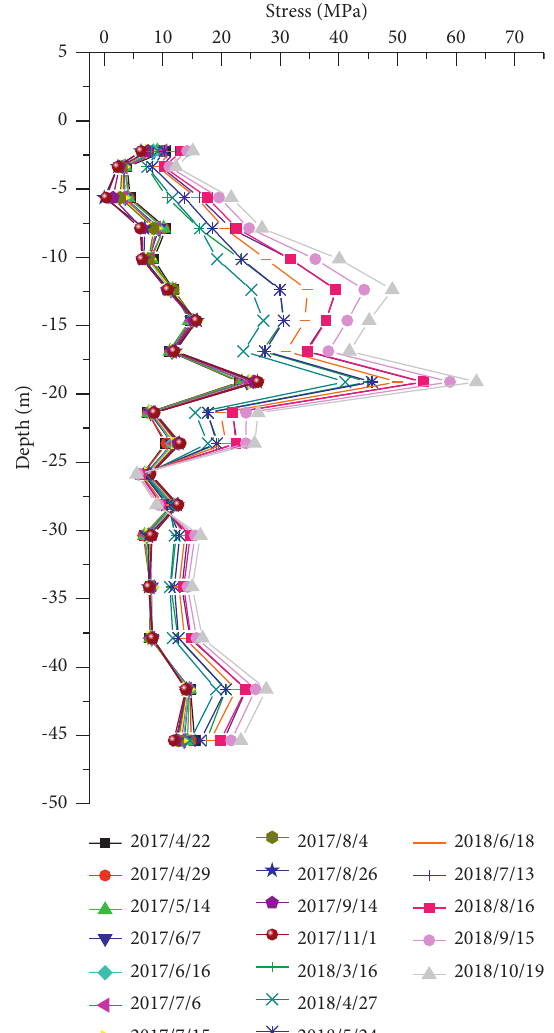
Figure 6: Body stress of 29# antislide pile during the rainy